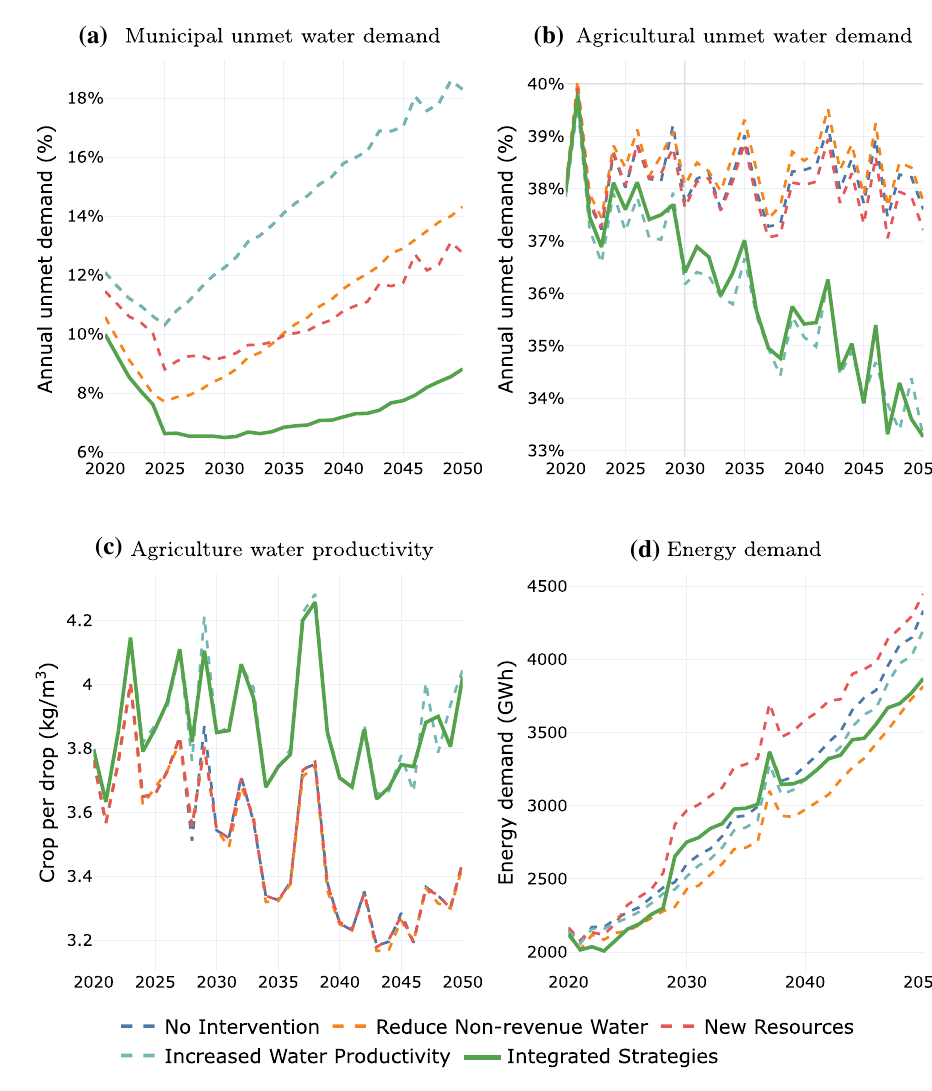
Fig. 7 Main results for all scenarios in an increased evapotranspiration future (i.e. warmer future), a unmet demand in the municipality sector (the No Intervention and the Increased Water Productivity scenarios have the exactly the same values, making both lines to